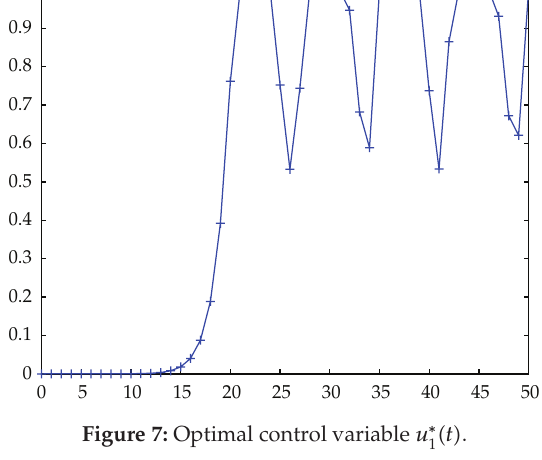
Figure 7: Optimal control variable u ∗